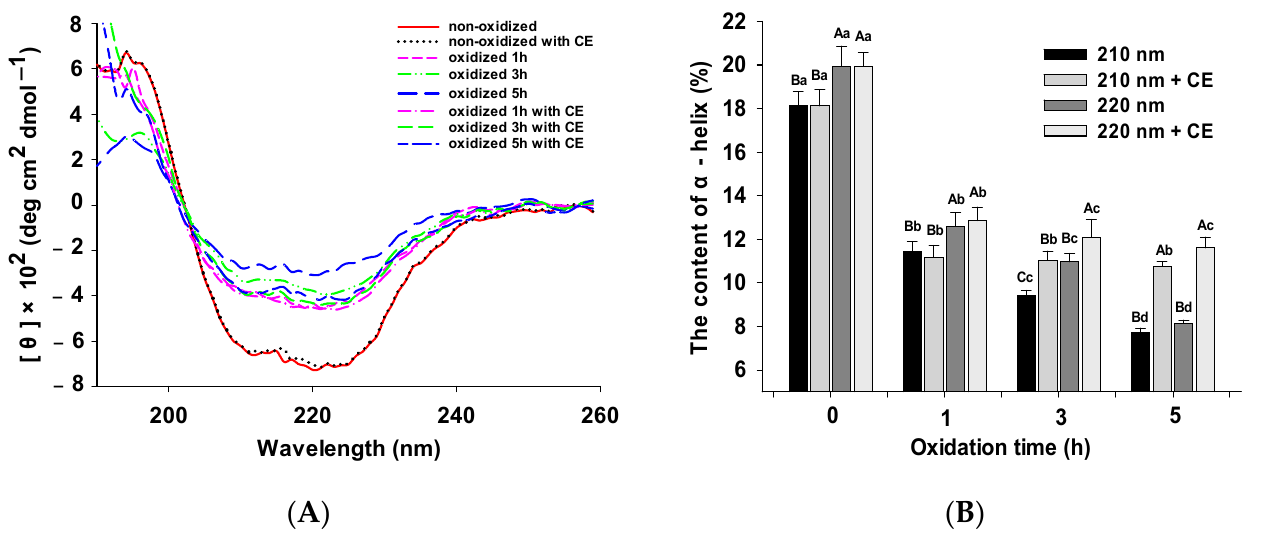
Figure 2. Effect of CE on circular dichroism (CD) spectrum ( A ) and α -helix content ( B ) of MPs under different oxidation times; [ θ ] is the mean residue ellipticity. Different capital letters indicate significant differences between different treatments under the same oxidation time ( p < 0.05); different lowercase letters indicate the same treatment with significant differences at different oxidation times ( p < 0.05).